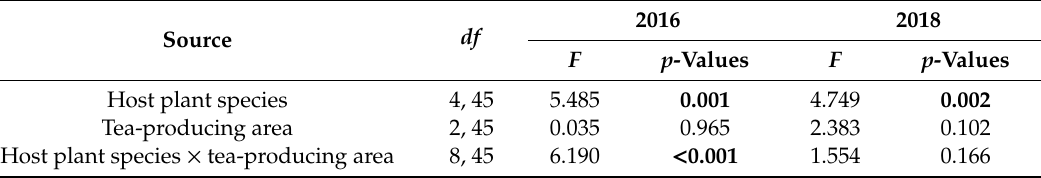
Table 2. GLM parameters for effects of host plant species and tea-producing area on the number of A. lucorum . Source df